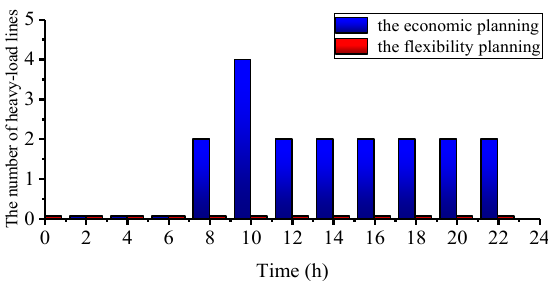
Figure 5. The number of heavy-load lines.